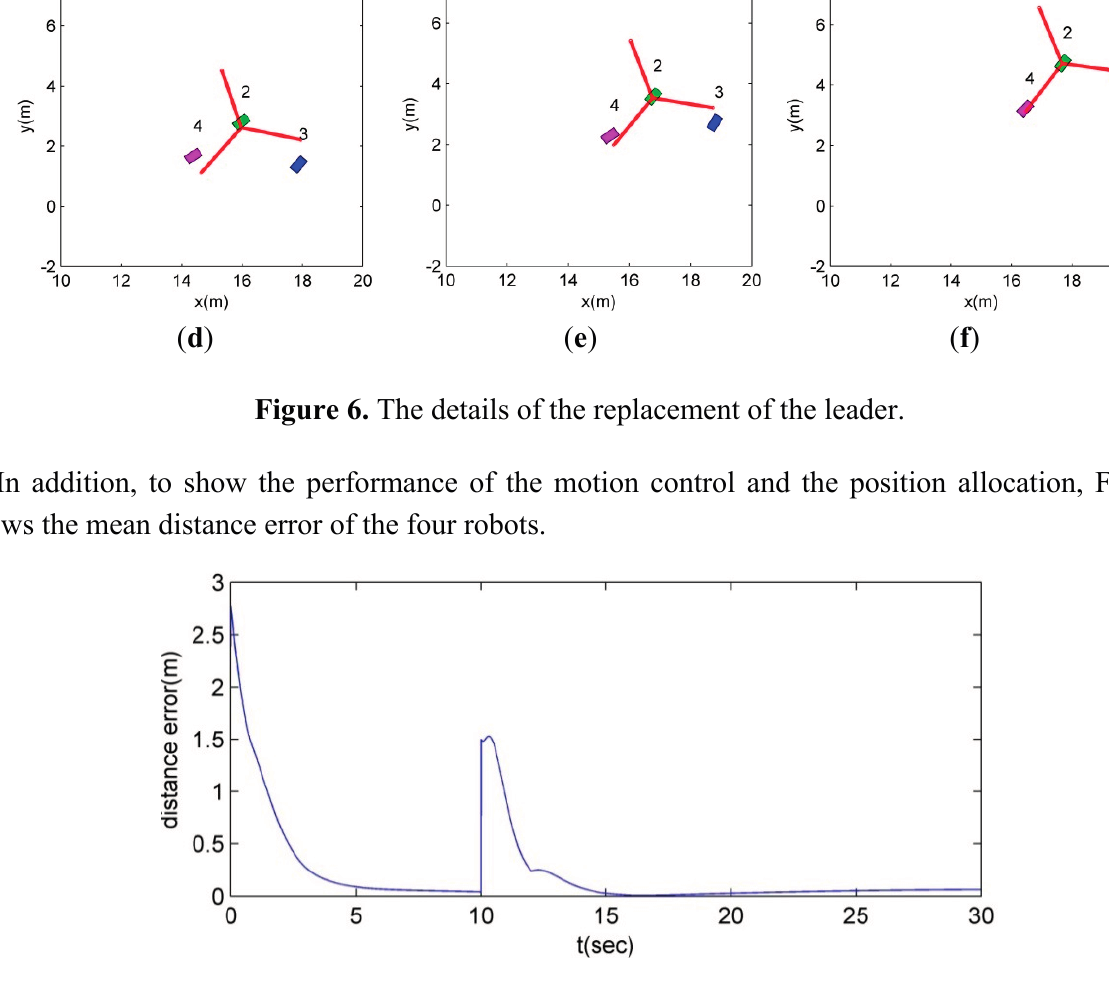
Figure 7. The competition of the followers for their